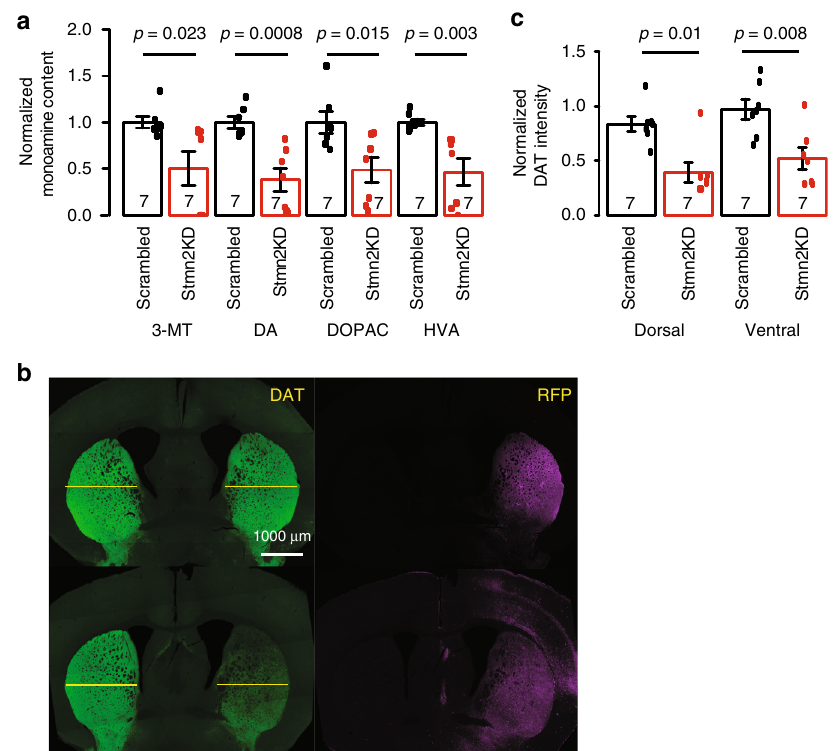
Fig. 6 Striatal alterations in mice with AAV-shRNA-mediated Stmn2 knockdown. a The content of dopamine (DA) and its major metabolites (3-MT, DOPAC, and HVA) were measured in the contralateral and ipsilateral striatal tissues isolated from the mice that received scrambled AAV and Stmn2 - shRNA AAV injections, N = 7 in each group. The biogenic monoamine levels of the ipsilateral striatum were normalized to those of the contralateral side in each individual mouse, and the comparison between mice with scrambled and Stmn2 -shRNA AAV injection was analyzed by two-sided Student ’ s t test. DA: t = 4.4367, df = 12, p -value = 0.0008; DOPAC: t = 2.8365, df = 12, p -value = 0.01499; 3-MT: t = 2.614, df = 12, p -value = 0.02263; HVA: t = 3.6415, df = 12, p -value = 0.003379. b Anti-DAT antibody was used to detect DAT + terminals in the striatum in mice that received scrambled AAV and Stmn2 - shRNA AAV injections. RFP serves as an indicator of transfected terminals. The yellow line separated the dorsal and ventral striatum. c The quantitative analysis of DAT + immuno fl uorescent intensity in the two groups of mice. The DAT fl uorescence intensity of ventral striatum without injection was used as the baseline to normalize the DAT intensity of the rest regions. N = 7 in each group. Two-way ANOVA, F = 25.689, df = 25, p = 3.12E-05. All data are present as mean ± SEM. Source data are provided as a Source Data fi